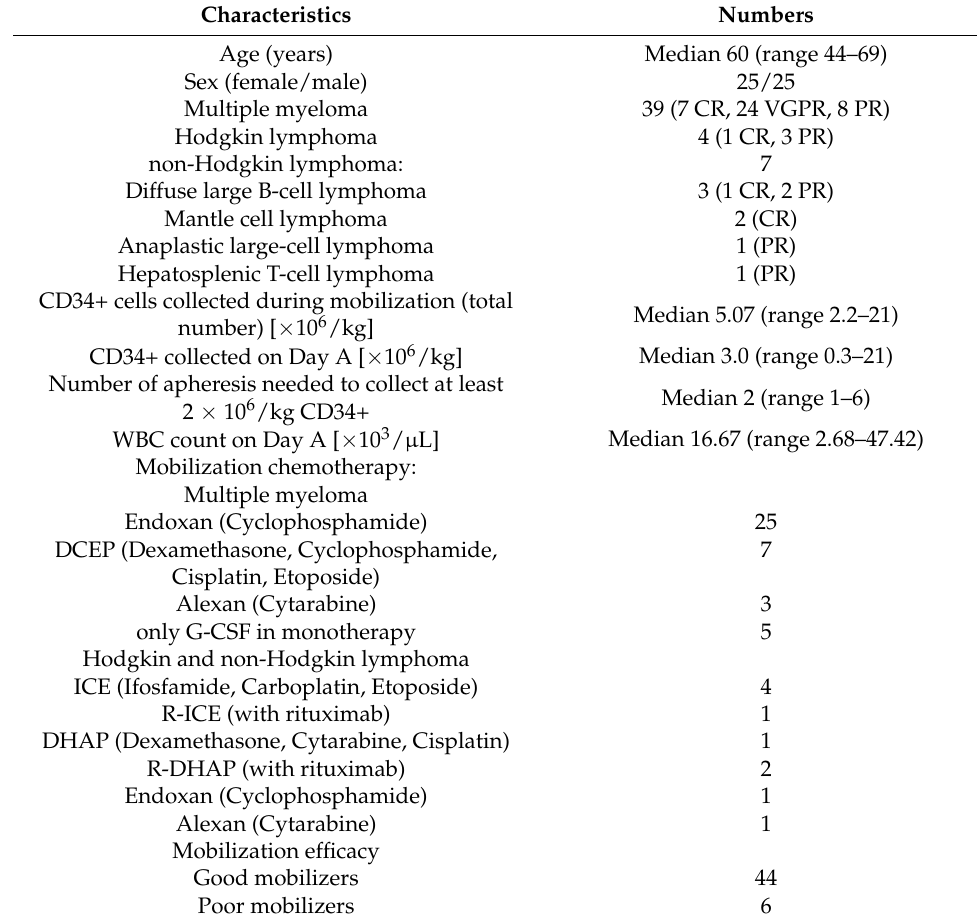
Table 1. Characteristics of the patients enrolled to the